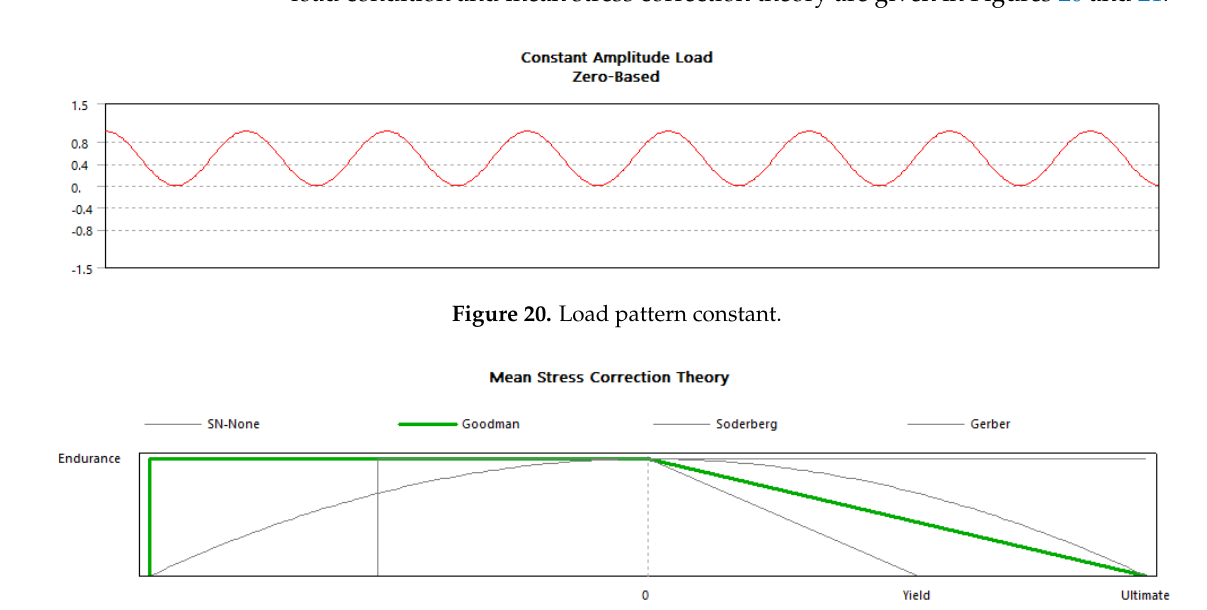
Figure 21. Mean stress correction theory.